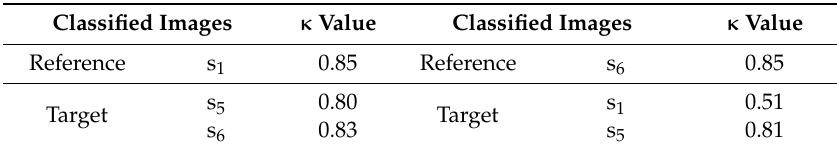
Table 4. The accuracy assessment results of shoreline images at threshold d = 0.5 generated from two reference subsets (s 1 and s 6 ).